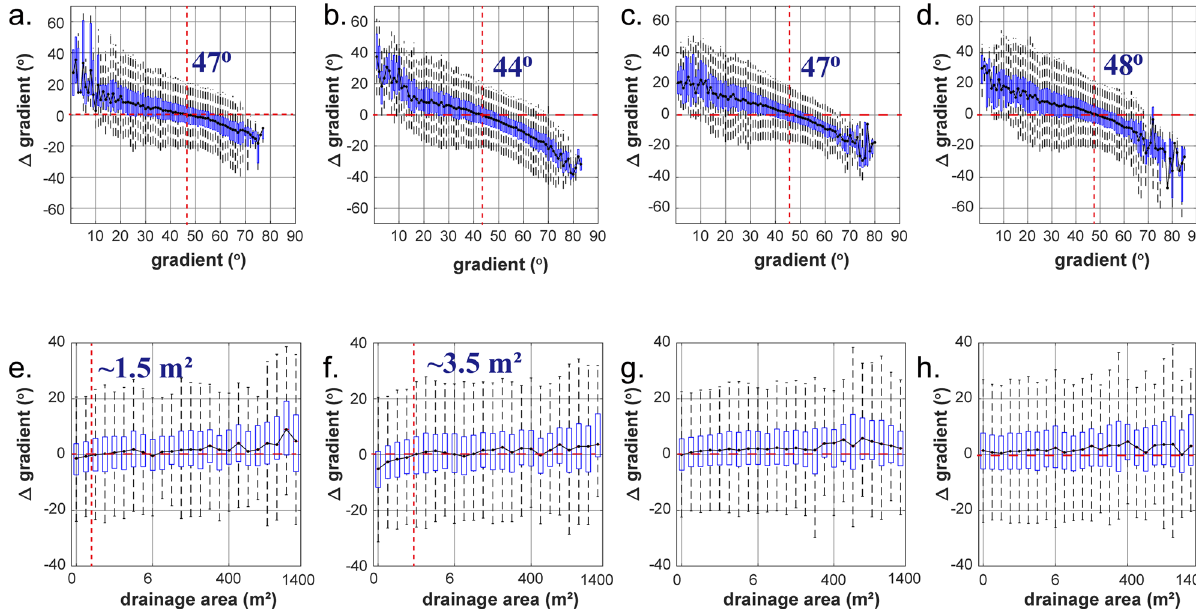
Fig. 3 Gradient change as function of hillslope gradient (a – d) and drainage area (e – h) for the four survey periods. Gray dots and error bars denote median and standard deviation of gradient change on each bin, respectively. Horizontal red dashed lines denote no gradient change and vertical red dashed lines denote the in fl ection of gradient change from steepening to fl attening. a , e Oct. 22, 2016 – Jun. 30, 2017 (monsoon). b , f Jul. 01, 2017 – Aug. 04, 2017 (typhoons). c , g Aug. 05, 2017 – Dec. 02, 2017 (winter precipitation). d , h Dec. 03, 2017 – May 25, 2018 (winter precipitation).